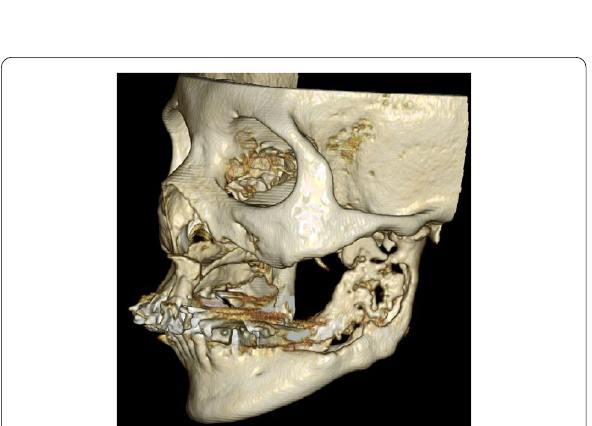
Fig. 2 Three-dimensional (3D) computed tomography (CT) imaging findings at the first examination. CT showed a bony sequestrum 45 25 mm in size at the site of the mandibular ×